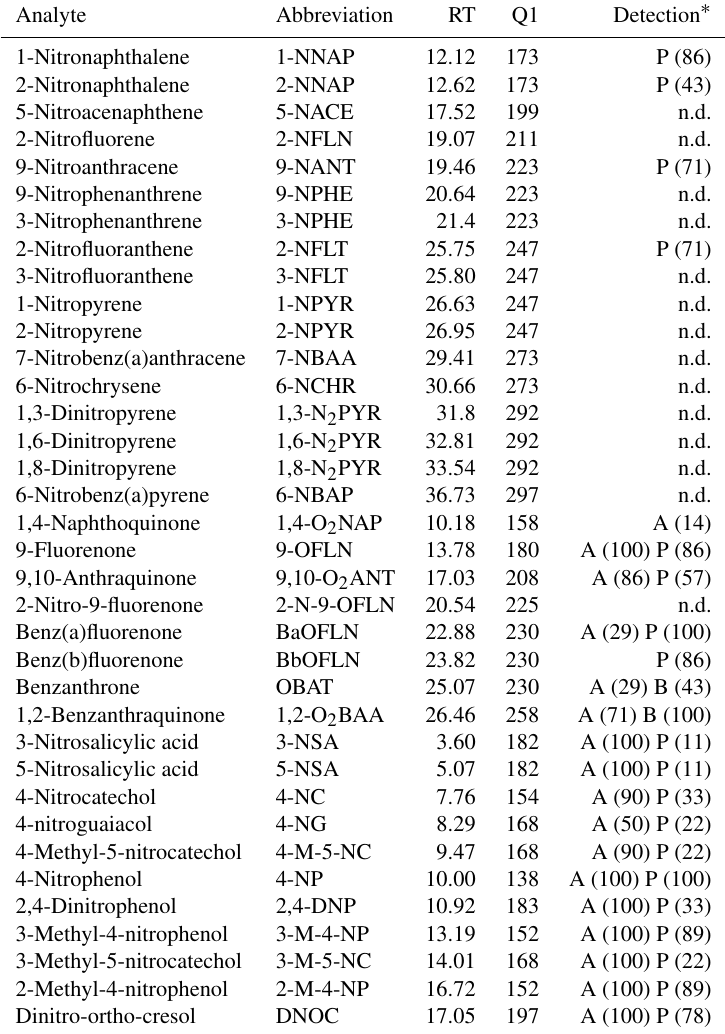
Table 2. Target compound